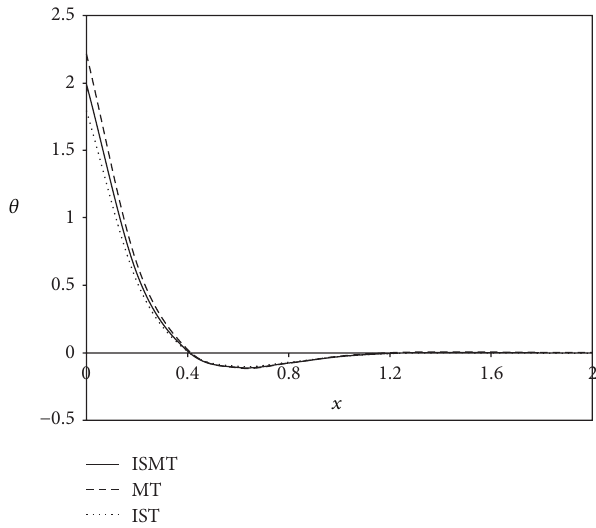
Figure 5: Temperature distribution 𝜃 at 𝛼 = 0.5 , 𝑡 = 0.1 .